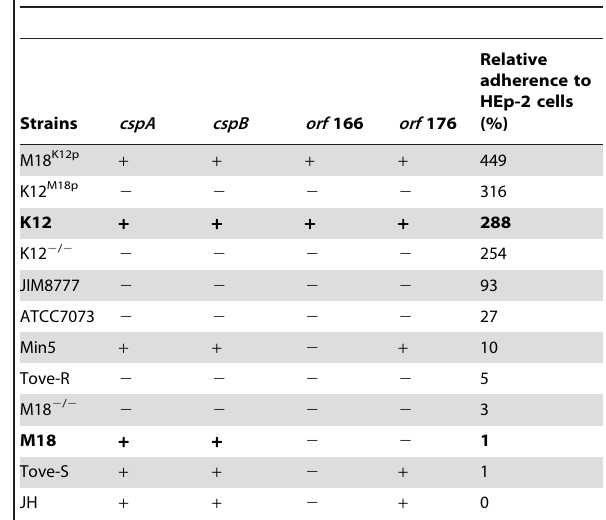
Table 2. The distribution of cspA , cspB , orf 166 and orf 176 in S. salivarius strains having differing adhesion capabilities to HEp-2